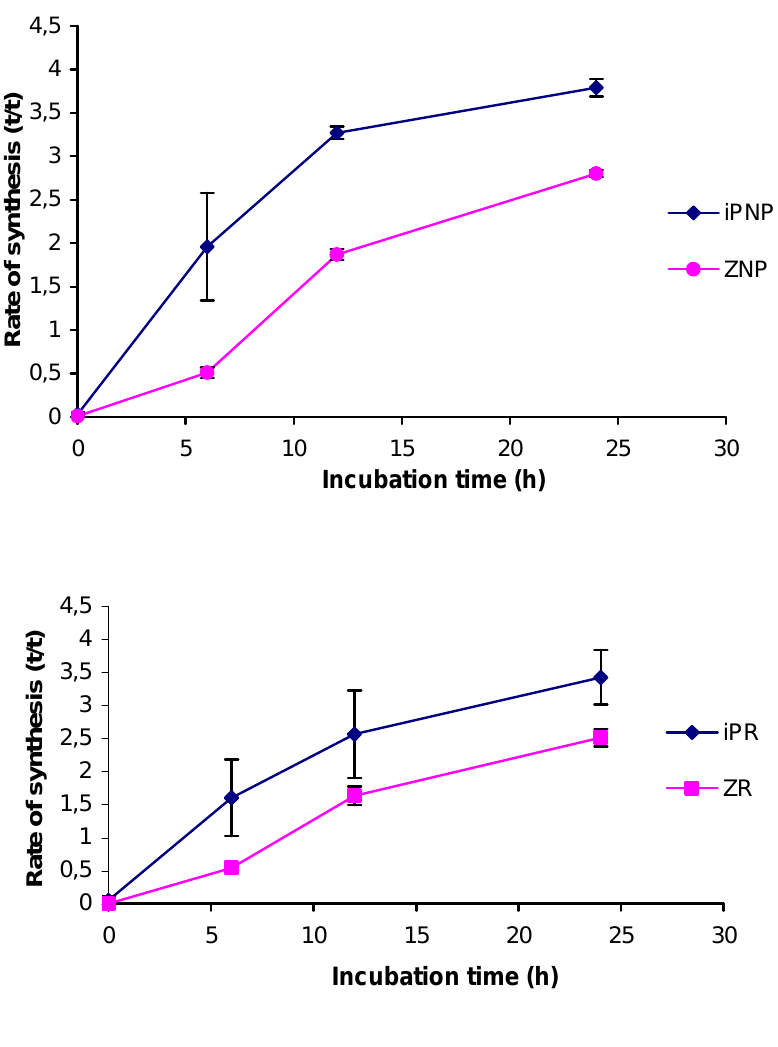
Figure 4. The biosynthetic rate (tracer:tracee ratio) of iP-type nucleotides (IPNP), tZ-type nucleotides (tZNP), iPR and tZR isolated from Arabidopsis line pga22 plotted against the incubation time. Data were acquired in MRM mode and include corrections to compensate for the natural isotope